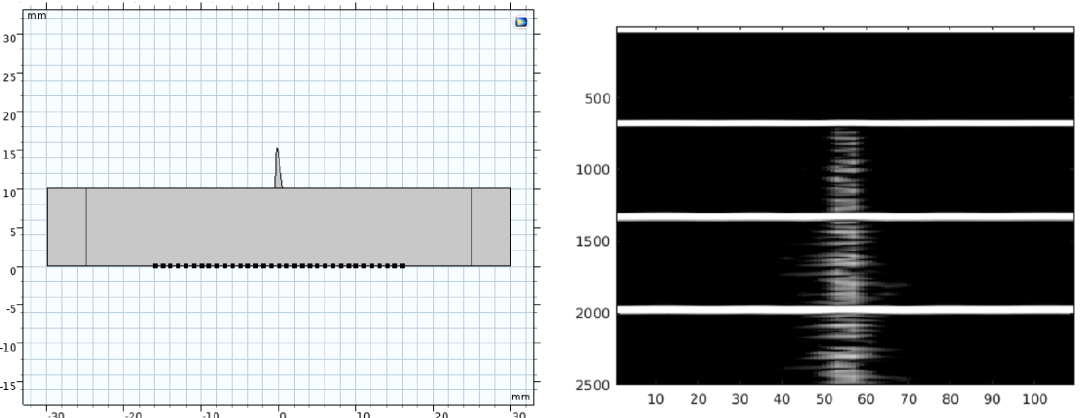
Figure 10. B-Scan imaging obtained at 4 MHz frequency in a new domain with a 1 mm length. Left, it is the simulation domain, and right the image result.